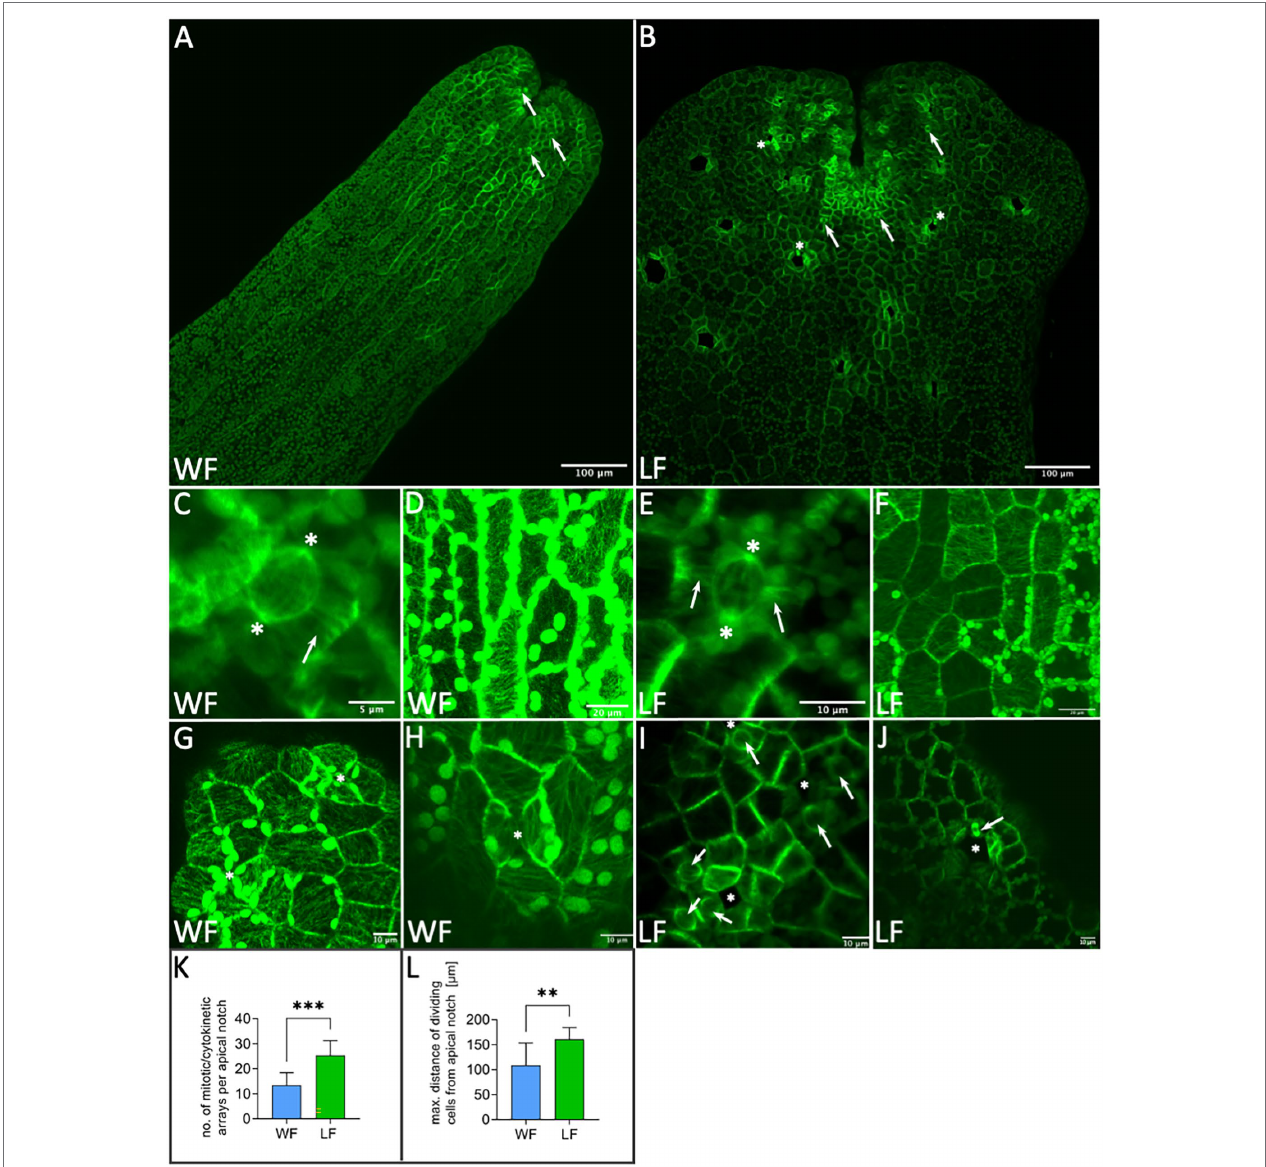
FIGURE 5 | Application of pro Mp EF1 α : GFP -Mp TUB1 for analyzing microtubules of Riccia fluitans . (A) Dorsal view of WF thallus and (B) LF thallus tip regions. Arrows in (A,B) point to meristematic cell division events. Cell divisions in LF air pore ring cells are marked by asterisks. (C) Cell division in WF and (E) LF thalli showing polar organizers (asterisks) and preprophase bands (arrows). Highly organized cortical microtubule network in the more elongated WF (D) and more squarish LF (F) dorsal epidermal thallus cells. (G) Air pore invaginations (asterisks) in young WF and (I) in LF, near the apical notch region. (H) Arrested WF air pore in posterior thallus region. Closure of invaginations by contact of two opposing cell walls is marked with an asterisk. (I) Young LF air pore invaginations are surrounded by cells preparing for cell division (arrows), as indicated by polar organizers. (J) Older LF air pore (asterisk) in a posterior thallus region showing a mitotic spindle in pore ring cells (arrow). (K) Cell division quantification for WF (blue) and LF (green; n = 10 apical notches, each form, *** p < 0.001). (L) Measurement of the maximal distance of cell division from the apical notch for WF (blue) and LF (green; excluding division in air pore ring cells; n = 10 apical notches, each form, ** p < 0.01). Scale bars: (A,B) 100 μ m; (C) 5 μ m; (D,F) 20 μ m; and (E,G–J) 10 μ